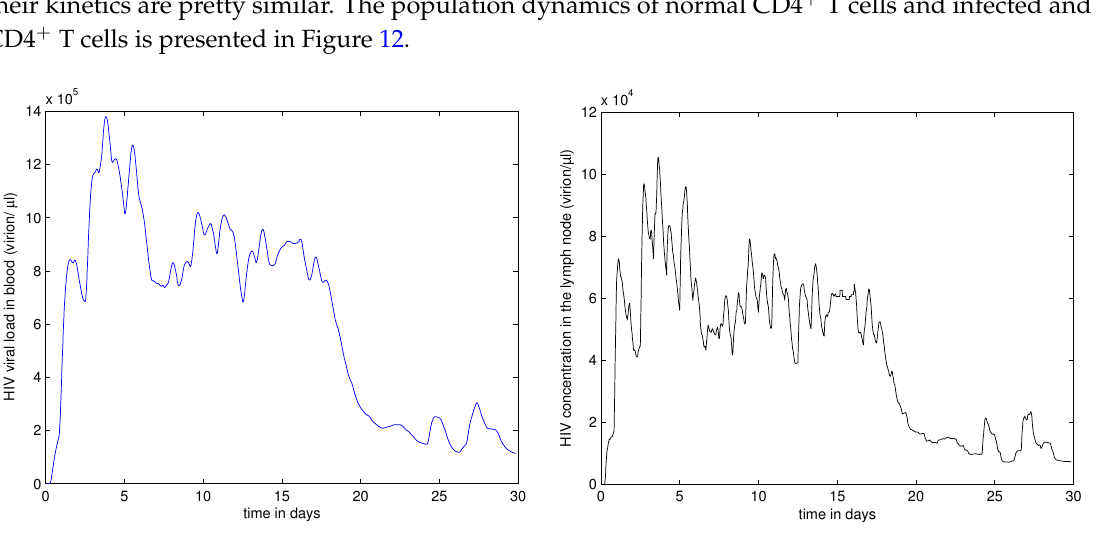
Figure 11. ( left ) The viral load in blood (virion/ µ L); ( right ) The HIV concentration in the lymph node over